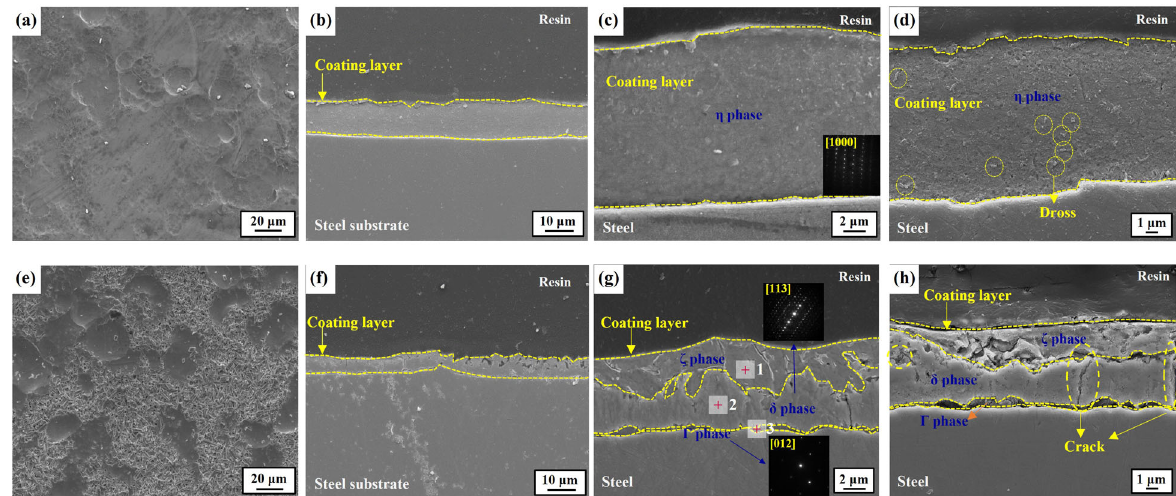
Fig. 3 FE-SEM images showing the microstructures of the coating layers. a, b Surface and cross-section morphologies of GI, respectively. c, d Magni fi ed images of b . e, f Surface and cross-section morphologies of GA, respectively. g, h Magni fi ed images of f .